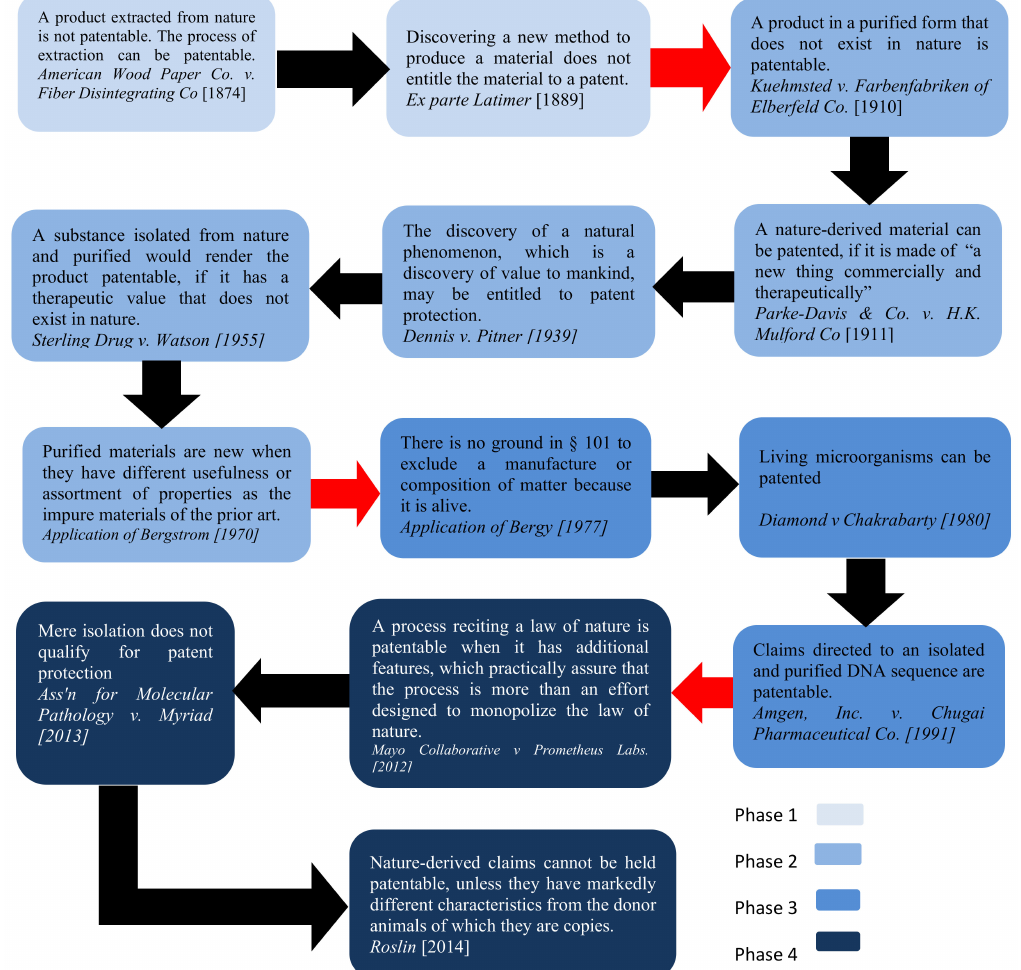
Figure 2. Evolvement of the assessment of nature-derived inventions in U.S. Patent System. Note: the red arrows demonstrate the transformation from phase to